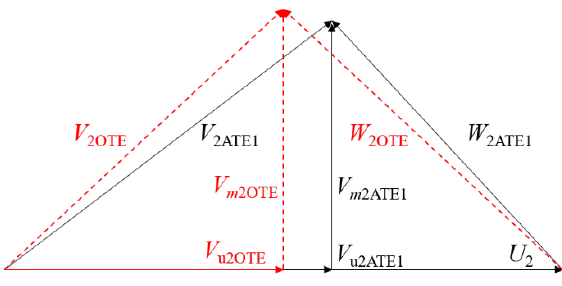
Figure 10. Outlet velocity triangle near the suction side of OTE and ATE1.